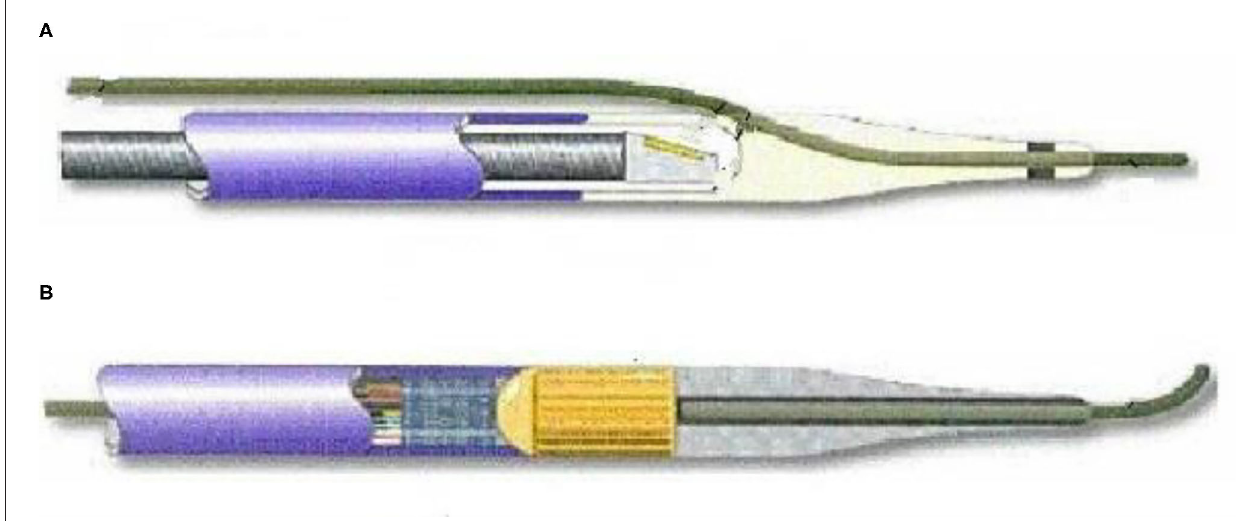
FIGURE 1 | Rotary and phased array ultrasound